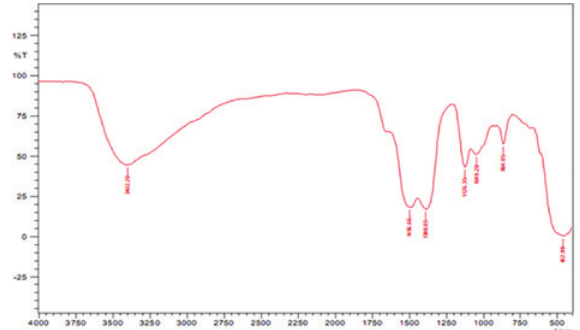
Figure 1: FT-IR spectrum of barberry